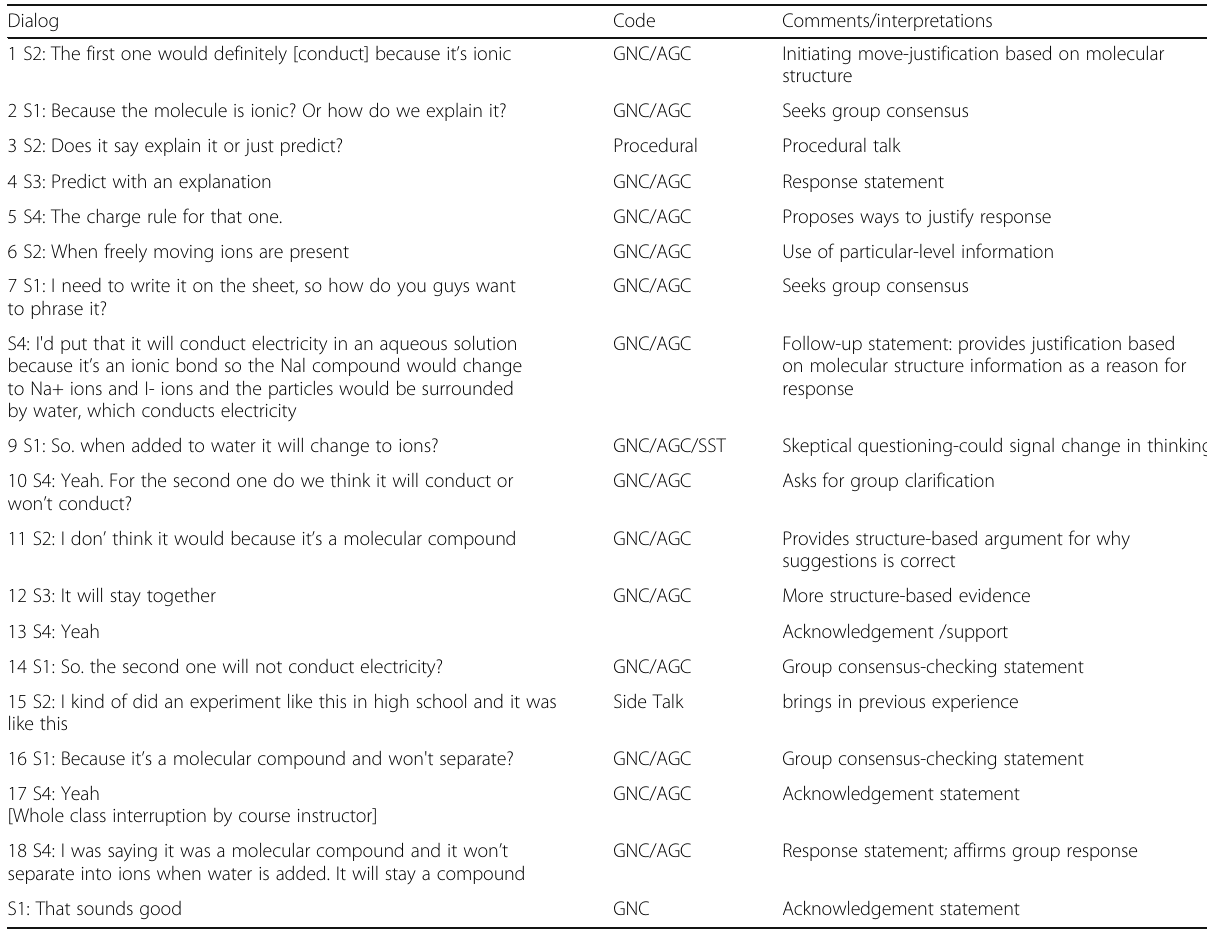
Table 6 Group 1A ’ s dialog on predicting conductivity of NaI and sucrose